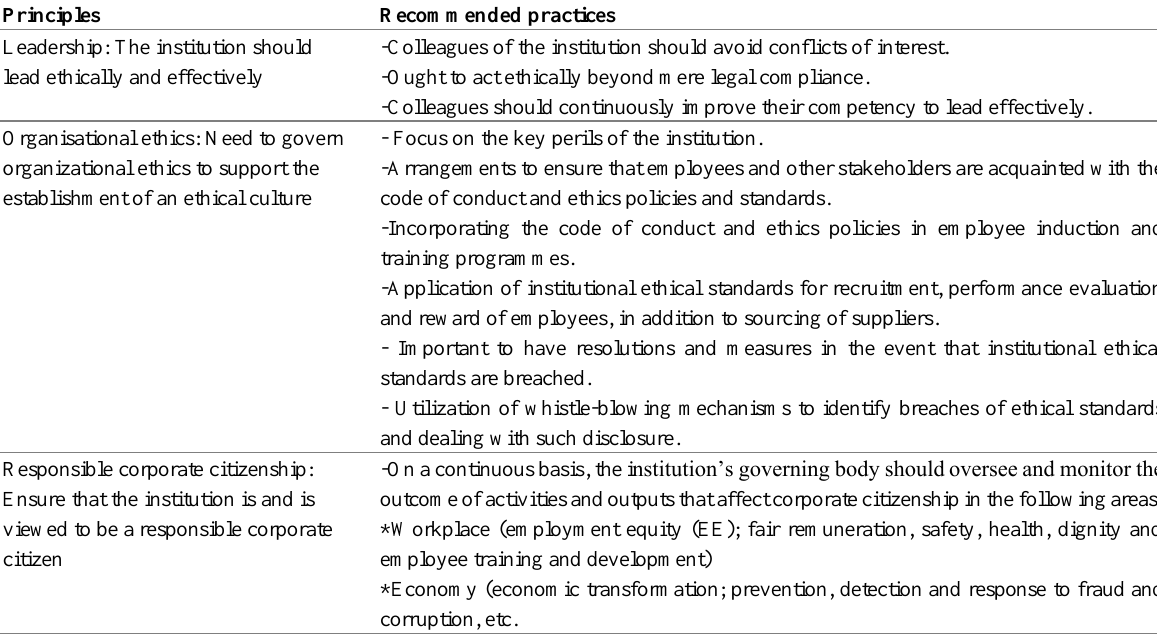
Table 1: Abridged King IV Code with Part 5.1.